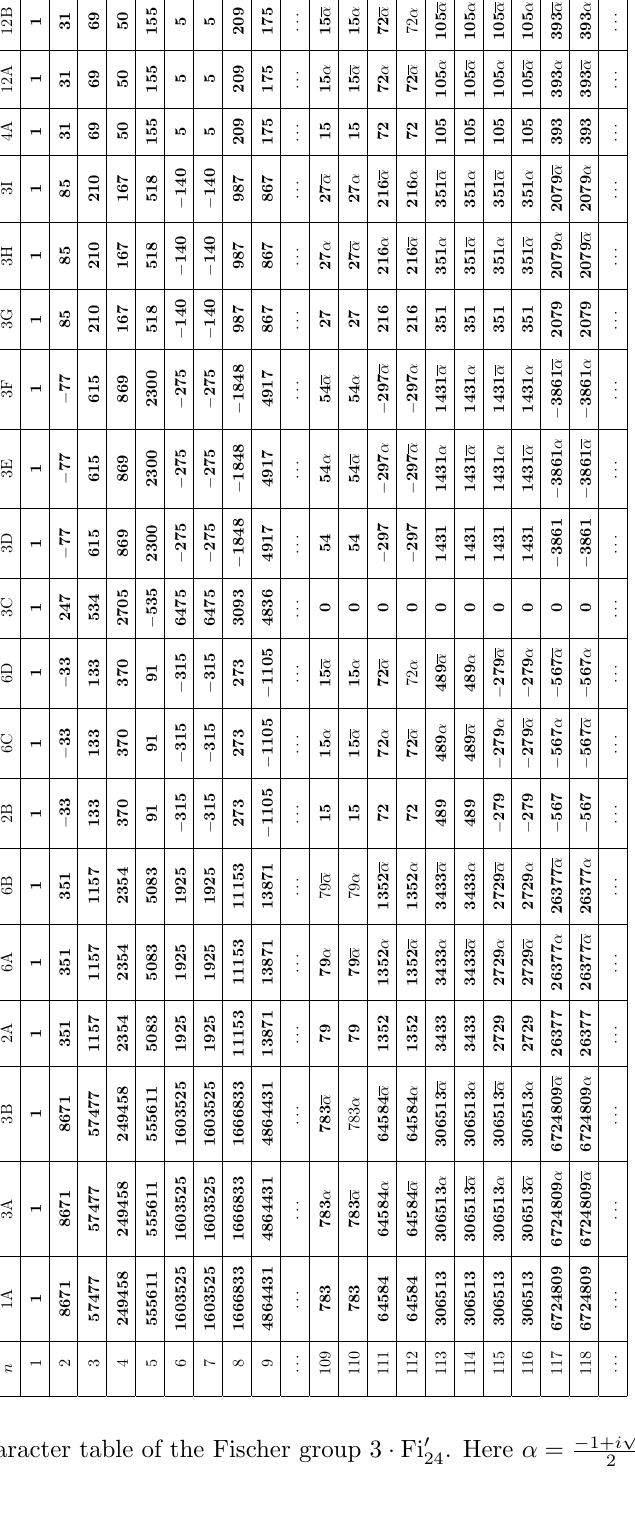
Table 3 . Partial character table of the Fischer group 3 (cid:1) Fi 0